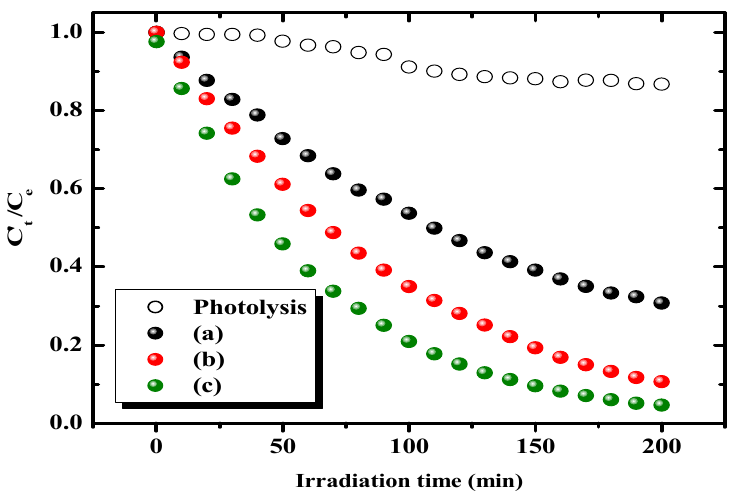
Figure 9. Photocatalytic MB degradation in aqueous medium using BiFeVOx.y catalysts for ( a ) y = 0.03, ( b ) y = 0.07, and ( c ), y = 0.15, under visible light irradiation.